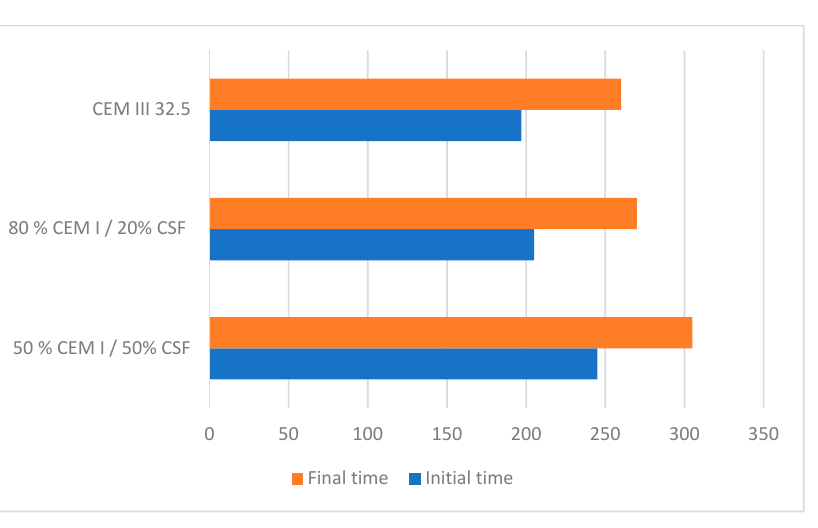
Figure 9. Cement setting times without setting retarder.